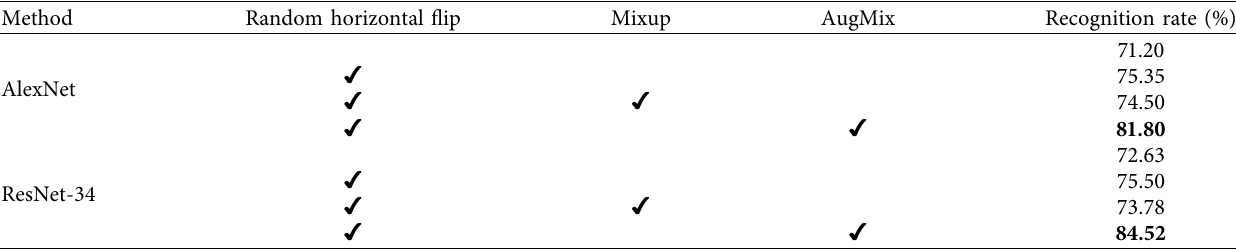
Table 8: Recognition rates of different data augmentation methods on AlexNet and ResNet-34. Method